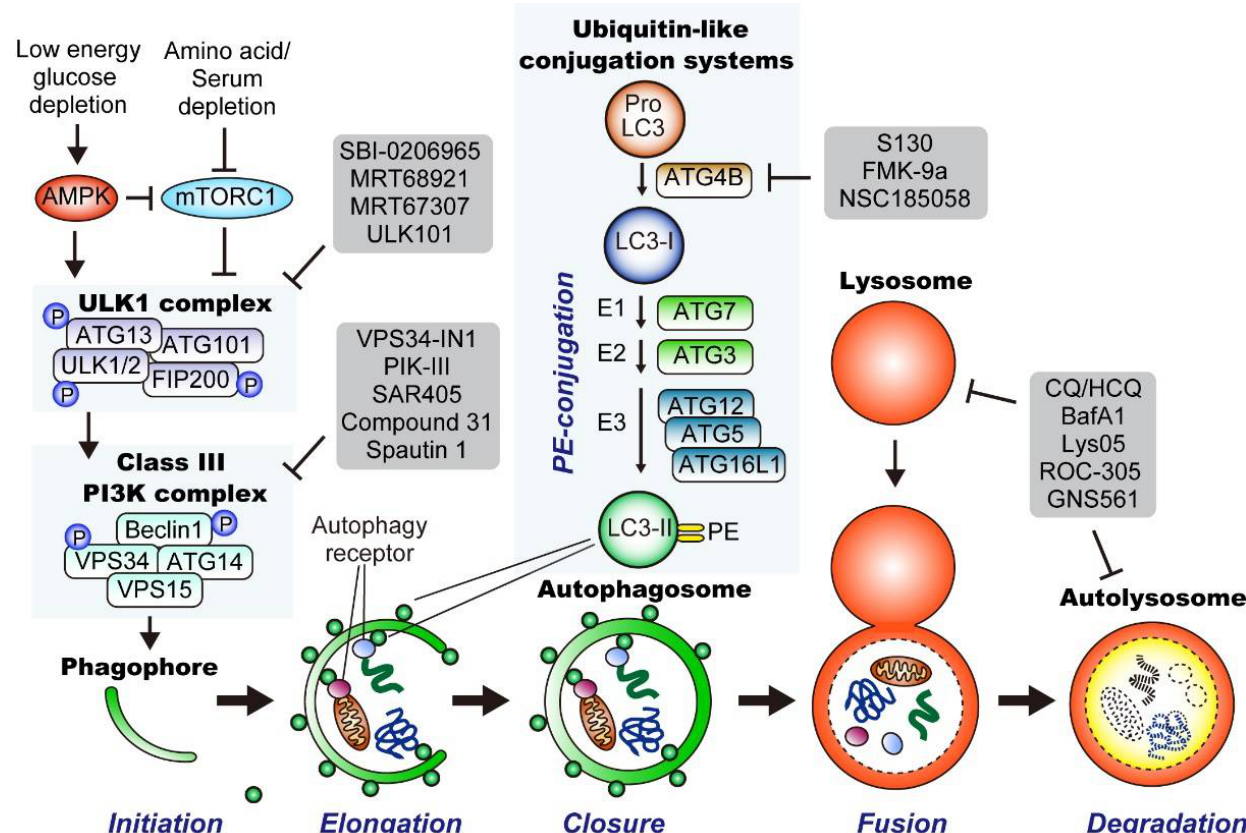
Figure 3. Overview of the general autophagy pathway in mammalian cells. (Bottom) Autophagy can be divided into five major steps: (1) Initiation and nucleation of the double-membrane phagophore, (2) elongation, (3) closure of the phagophore to form the autophagosome, (4) autophagosome-lysosome fusion; and (5) lysosomal degradation and nutrient recycling. (Top left) Upon activation by AMP-activated protein kinase (AMPK), the unc-51-like autophagy activating kinase 1 (ULK1) complex (also known as the preinitiation complex) initiates autophagy by activating the class III phosphatidylinositol 3-kinase (PI3K) complex (also known as the initiation complex) via phosphorylation of Beclin1 and VPS34. Thereafter, the activated class III PI3K complex generates phosphatidylinositol 3-phosphate (PI3P) at the site of nucleation of the phagophore from ER, leading to the binding of PI3P-binding proteins, such as WIPI proteins, that are required for phagophore maturation. (Top middle) ProLC3 is cleaved by ATG4B and to produce LC3-I. Thereafter, LC3-I is conjugated to phosphatidylethanolamine (PE) with a series of ubiquitin-like conjugation reactions that include the E1 ligase (ATG7), E2 ligase (ATG3), and the E3 ligase complex that is composed of ATG12, ATG5, and ATG16L. PE-conjugated LC3, termed LC3-II, is inserted into the phagophore membranes, where LC3-II promotes phagophore elongation and closure. LC3B-II also works as a docking site of autophagy receptor proteins, facilitating the trafficking of their cargos to the autophagosome, a process known as selective autophagy. Multiple inhibitors have been developed so far, which are shown in gray frames. ULK, Unc-51-like kinase; PI3K, phosphatidylinositol 3-kinase; PI3P, phosphatidylinositol 3-phosphate; ER, endoplasmic reticulum; WIPI, WD-repeat protein interacting with phosphoinositide; mTORC1, mammalian target of rapamycin complex 1; AMPK, 5′ AMP-activated protein kinase; PE, phosphatidylethanolamine. Figure 3 is adapted from reference [41], the use of which is licensed under a Creative Commons Attribution 4.0 International license https://creativecommons.org/licenses/by/4.0/.